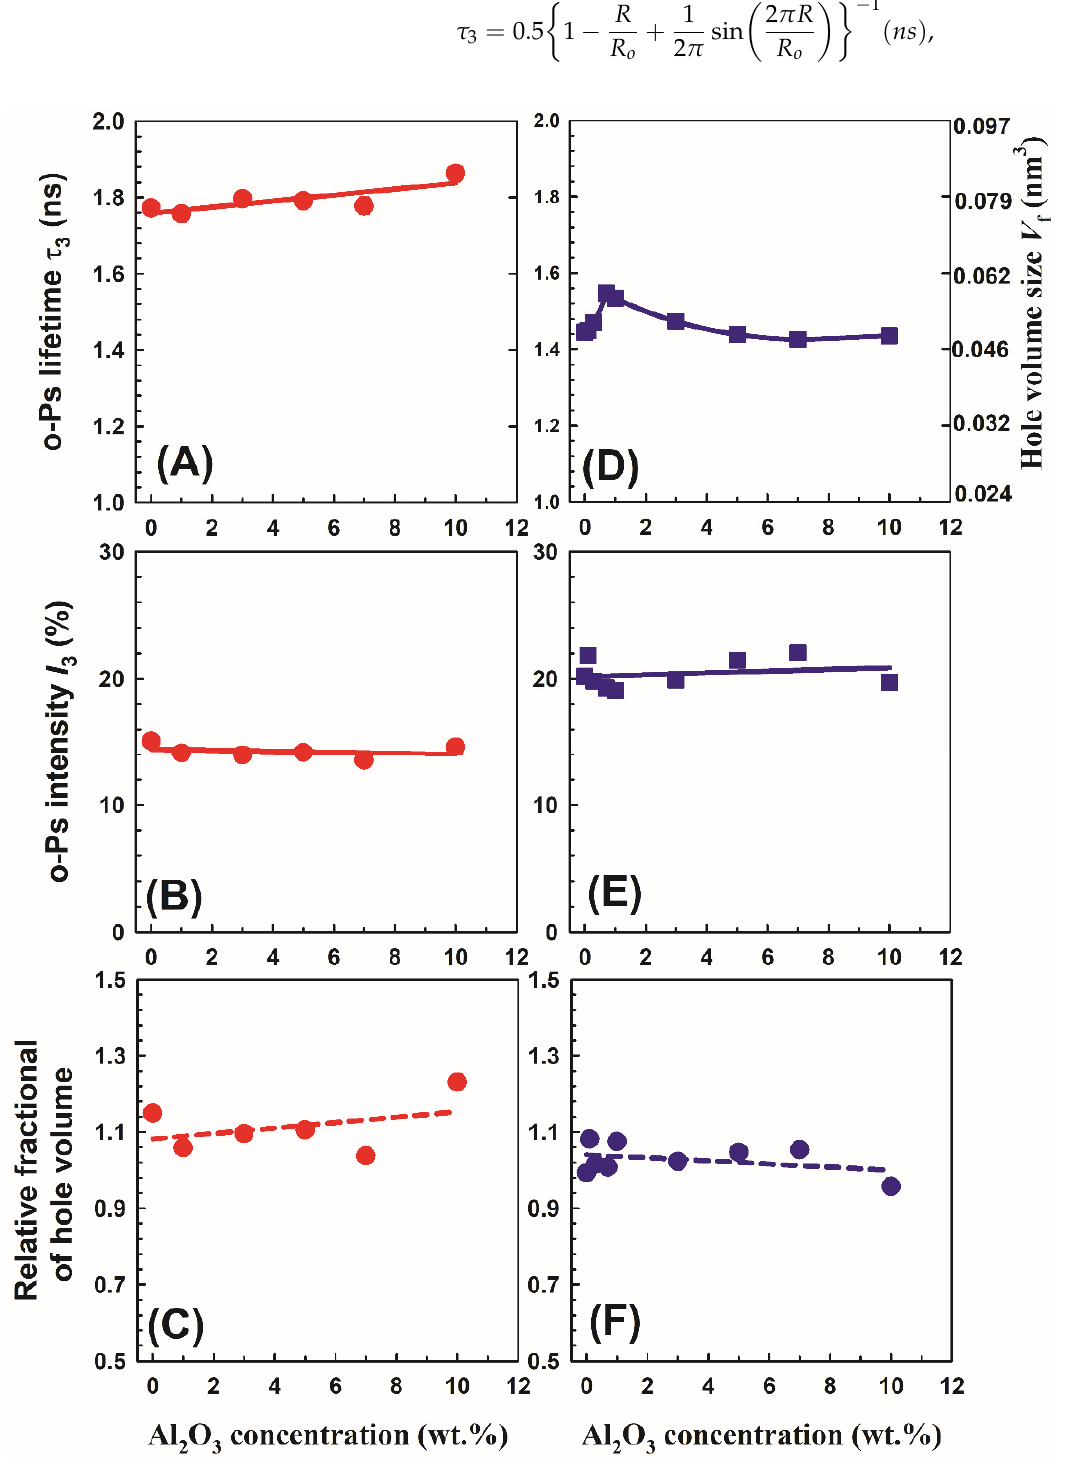
Figure 10. The o -Ps lifetime τ 3 , its intensity I 3 , and relative fractional of hole volume f r as a function of Al 2 O 3 concentrations on PVA/10 wt.% PEG polymers ( A – C ) and PVA/10 wt.% PEG/20 wt.% SSA membranes ( D – F ), respectively. Included in the right top plot is the hole volume size V f calculated using Equations (8) and (9).